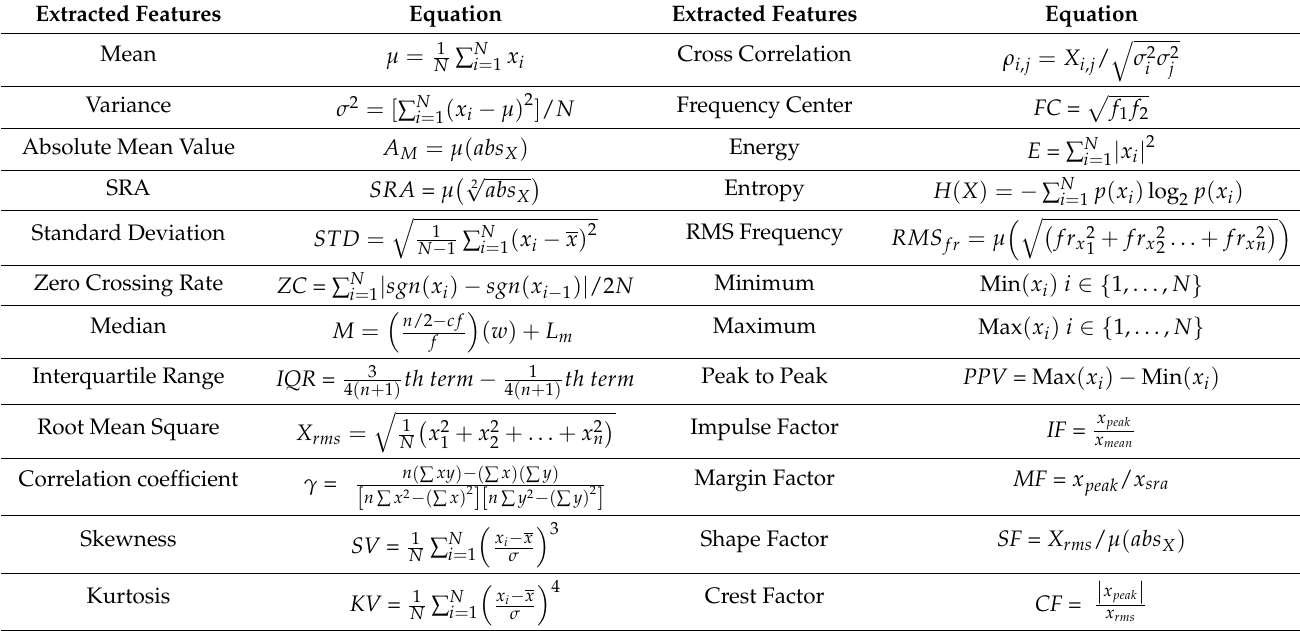
Table 1. Common features extracted from inertial sensor